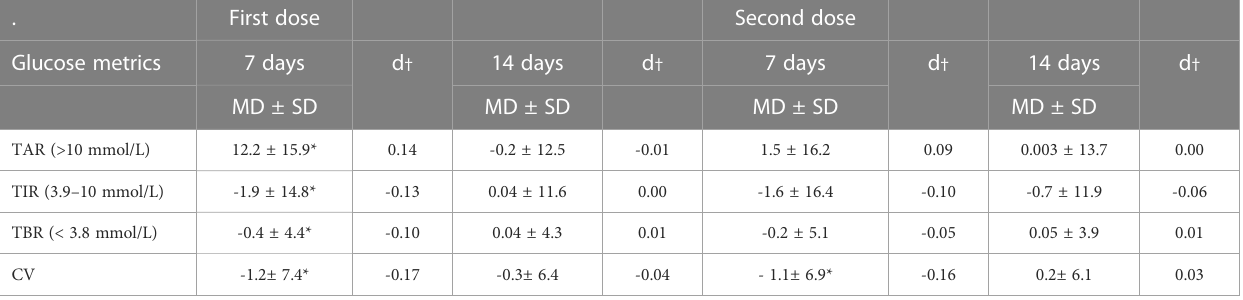
TABLE 2 Changes in glucose metrics (%) after COVID-19 vaccine in people with type 1 diabetes. . First